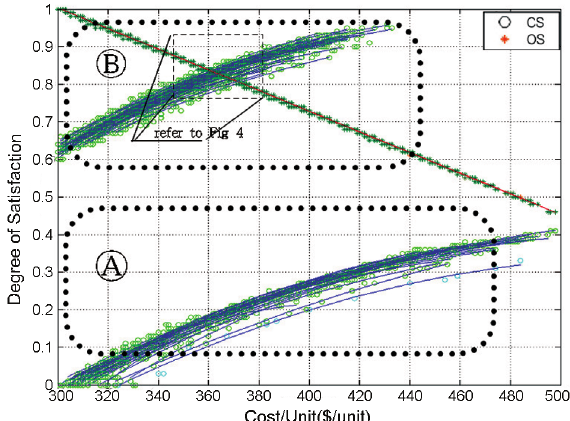
Fig. 3. Trade-offs according to the varying mutation and crossover rates